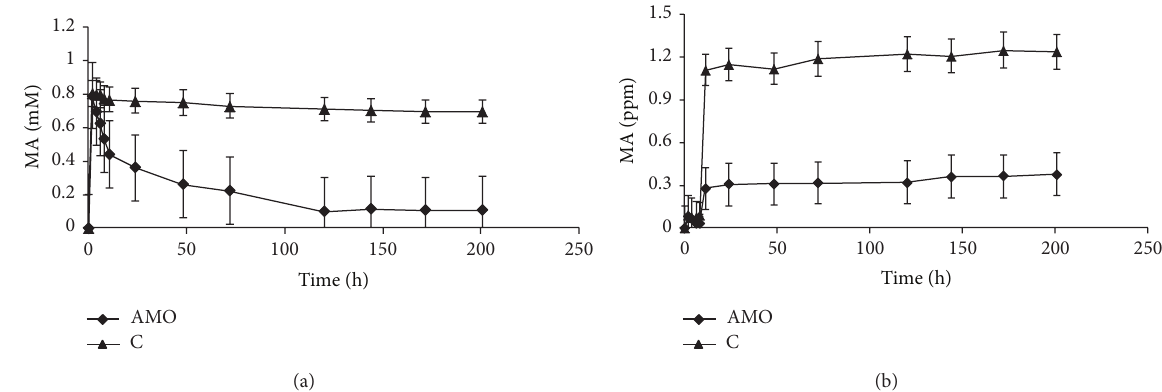
Figure 6: MA concentration in the aqueous (a) and in the gaseous (b) phase of the CFBR upon oxidation of MA in the 132mL min −1 air flow with 10ppm MA inlet concentration by immobilized AMO at the 13.3 Ug −1 CA loading. C (control) blank beads of the CA-gel tested at the same inlet